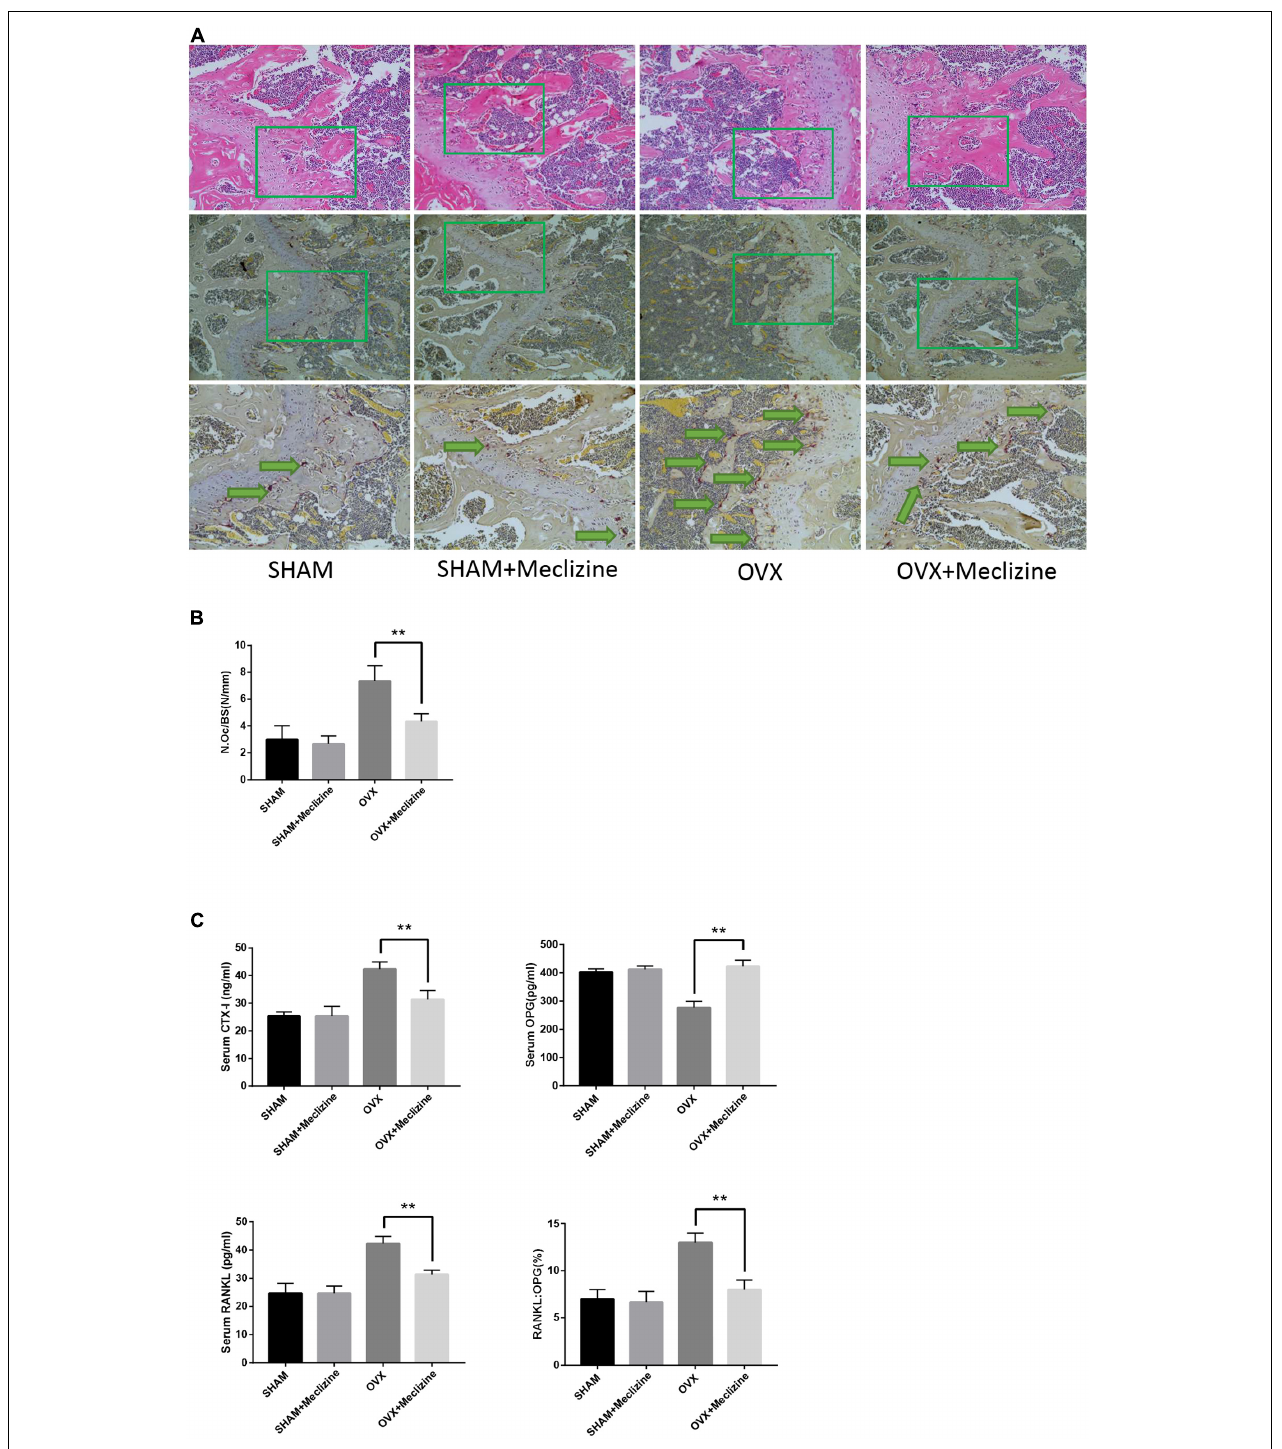
FIGURE 5 | Meclizine reduces OVX-induced osteoclast formation and decreases the serum levels of CTX-I, OPG and RANKL. (A) The paraffin-embedded bone sections of distal femurs were stained for H&E and TRAP. (B) The osteoclast number/bone surface was quantified. Data represent as mean ± SD. n = 10. ∗∗ P < 0.01. (C) Serum levels of CTX-I, OPG, and RANKL were determined by ELISA. Data are presented as mean ± SD. n = 10. ∗∗ P < 0.01.